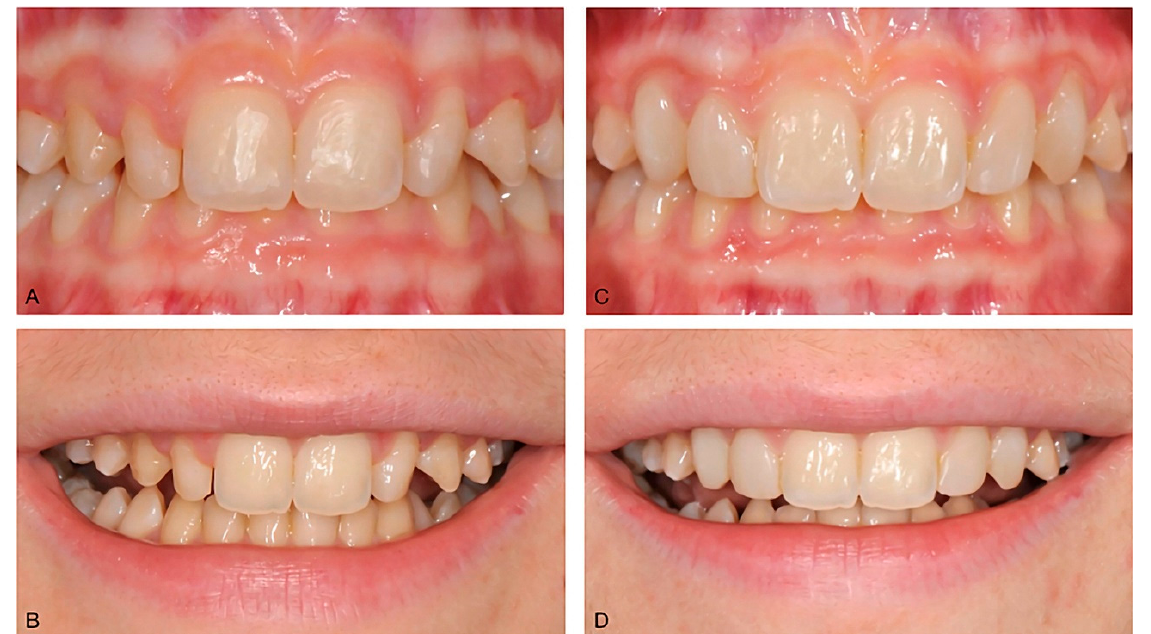
Figure 4. ( A ) A peg-shaped upper left lateral incisor. ( B ) The patient was treated using the BAIR technique. The volume of composite added to restore a shape similar to a normal lateral incisor can be seen in transparency. ( C ) The final result.